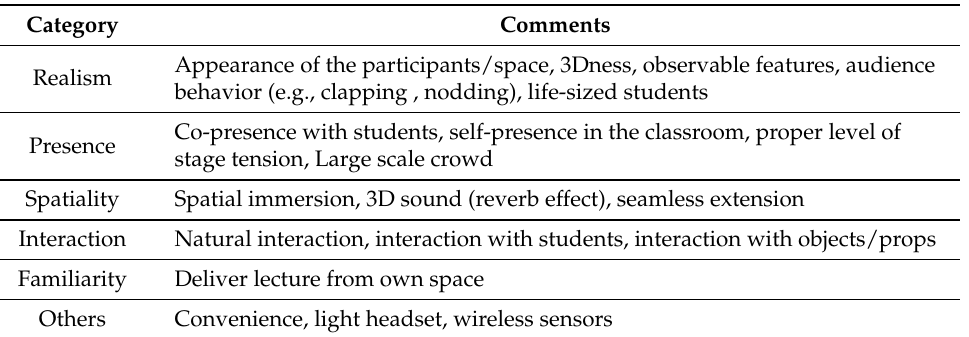
Table 1. Aspects considered in the design of AudienceMR including feedback from the pilot survey with educators on promoting a fluid, natural, and effective content